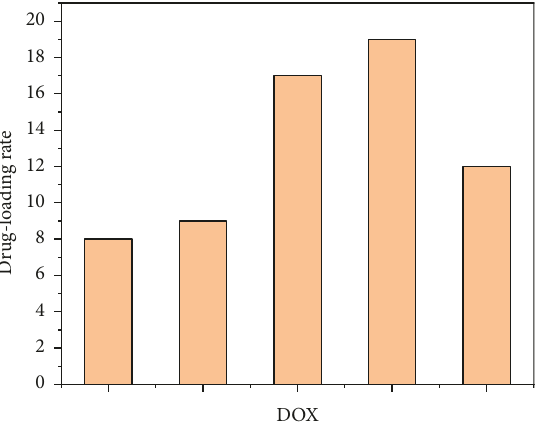
Figure 3: Drug loading concentration.